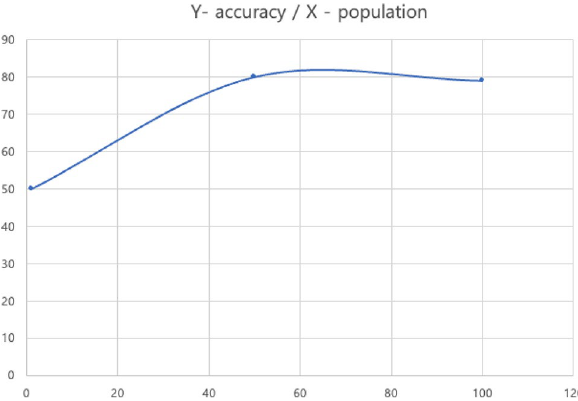
Figure 5. Accuracy flowchart by